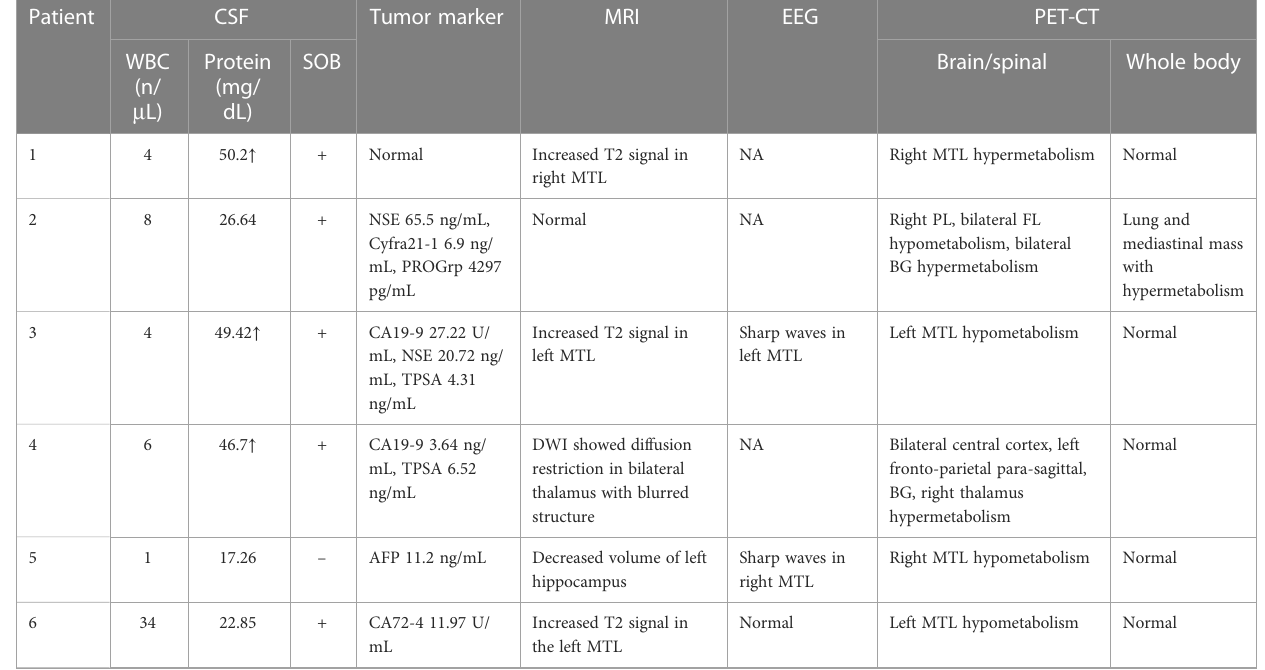
TABLE 2 Laboratory and neuroimaging data of anti-amphiphysin encephalitis.